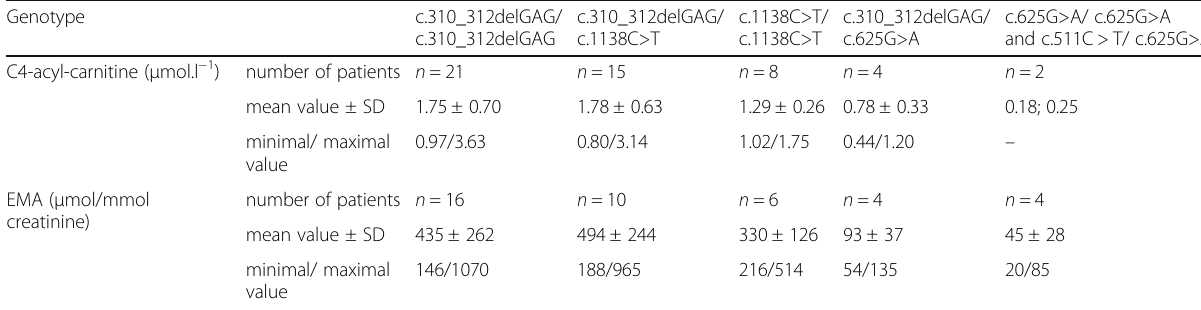
Table 5 The comparison of C4-acylcarnitine and EMA values in the cohort of SCAD-deficient patients sorted according to genotype Genotype